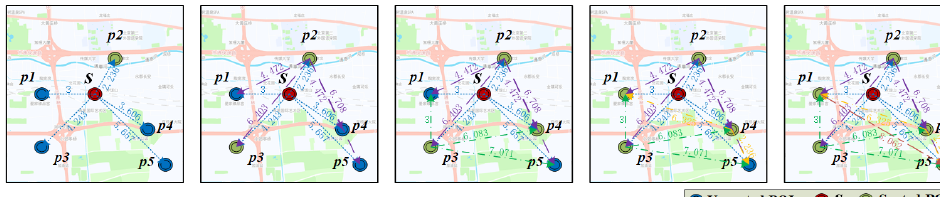
Figure 2. Example of spatial